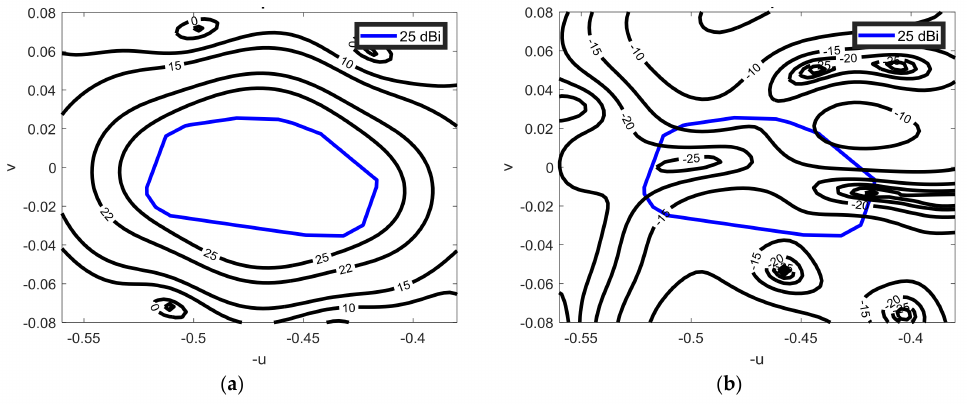
Figure 2. Synthesized pattern for vertical polarization at 13.75 GHz superimposed to the coverage mask: ( a ) co-polar component; ( b ) cross-polar